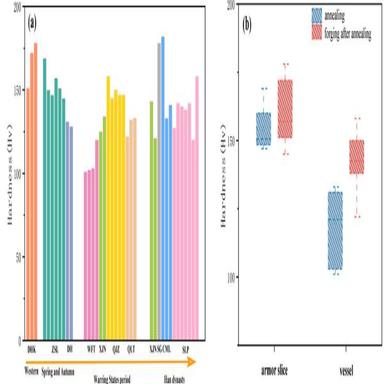
a) Hardness of the bronze samples, showing little changes in hardness with time; b) The image shows the difference in hardness between armor slices and vessels, as well as the difference between objects left in annealing and those that underwent forging after annealing.